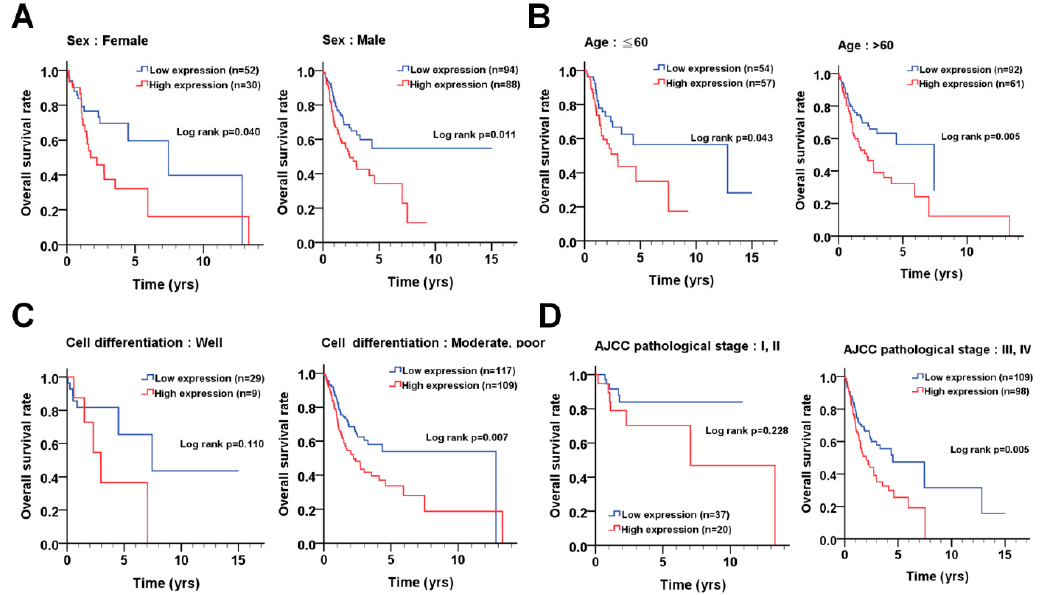
Figure 5. The association of PLK1 (polo-like kinase 1) gene expression with overall survival in certain groups of OSCC (oral squamous cell carcinoma) patients. ( A ) Kaplan-Meier plots were used for the stratified analysis to determine the association of PLK1 expression with survival based on sex, ( B ) age (60 years old), ( C ) differentiation, and ( D ) AJCC (American Joint Committee on Cancer) pathological stages. The cutoff values for the high or low expression of PLK1 in tumor tissues were based on the receiver operating characteristic (ROC) curve. The gene expression data and clinical information of OSCC are obtained from the TCGA dataset.